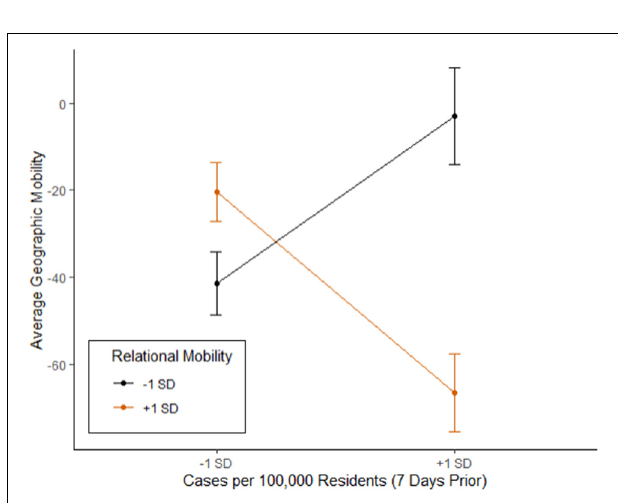
FIGURE 3 | Changes in geographic mobility predicted by case levels 1 week prior, as a function of relational